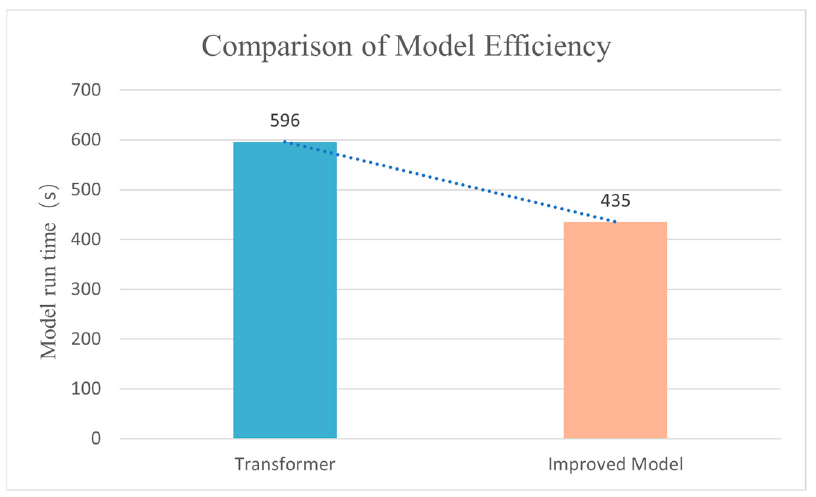
Figure 7. Model e ffi ciency comparison chart. Figure 7. Model efficiency comparison